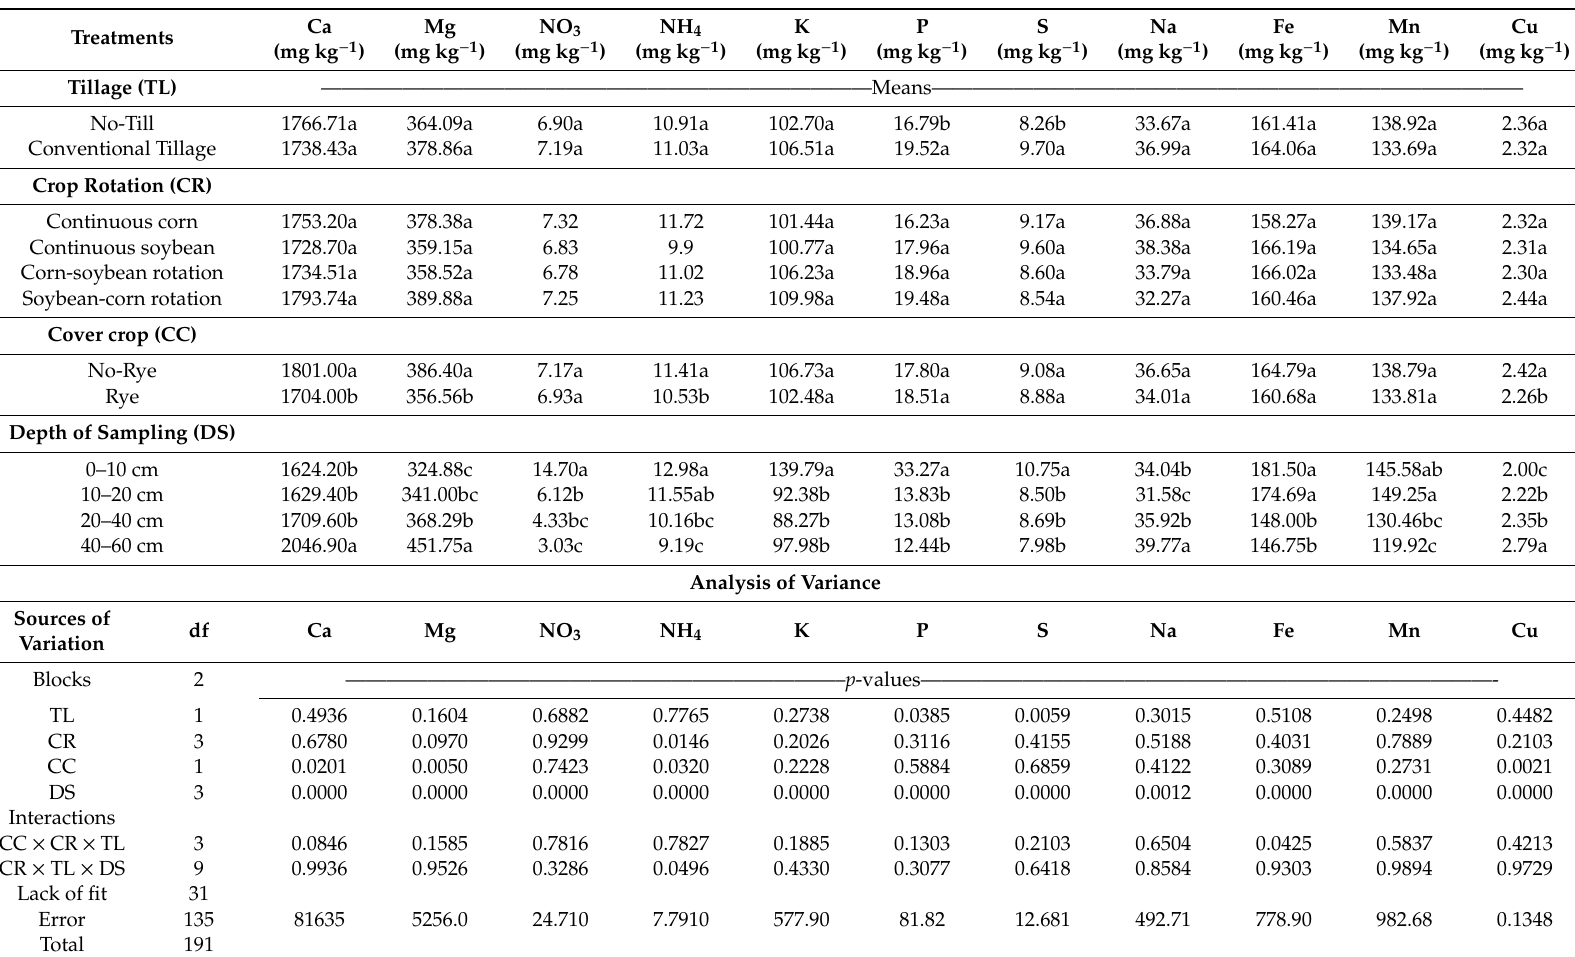
Table 3. E ff ects of tillage, crop rotation, cover crop and depth of sampling on selected soil nutrients in